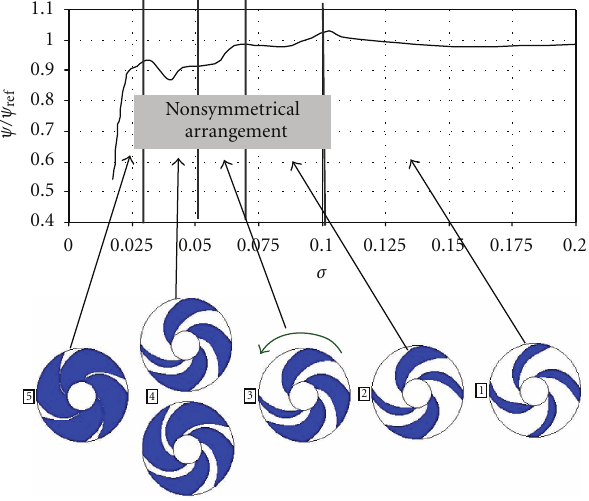
Figure 1: Sketches of cavitation patterns and performance evolu- tion as the cavitation number decreases in a four-blade inducer [9].